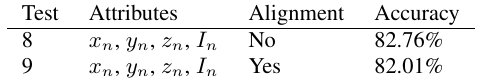
Figure 3: Comparison between reference points (above) and clas- sified points (below). Blue represents ground points